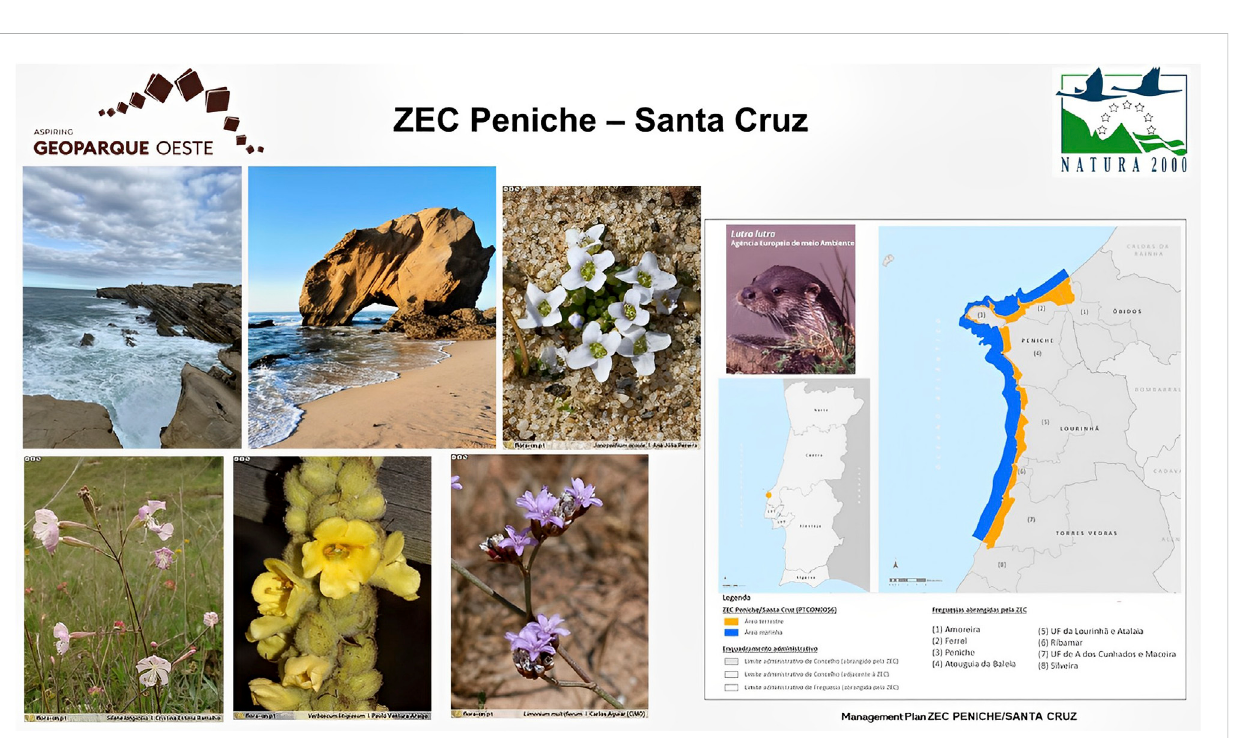
FIGURE 5 Peniche-Santa Cruz special conservation area. Source: produced by the authors.